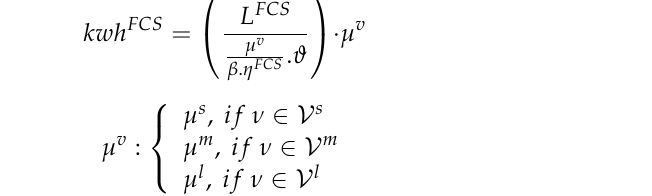
Figure 8. Average battery state of charge at the start of charging events at an FCS.